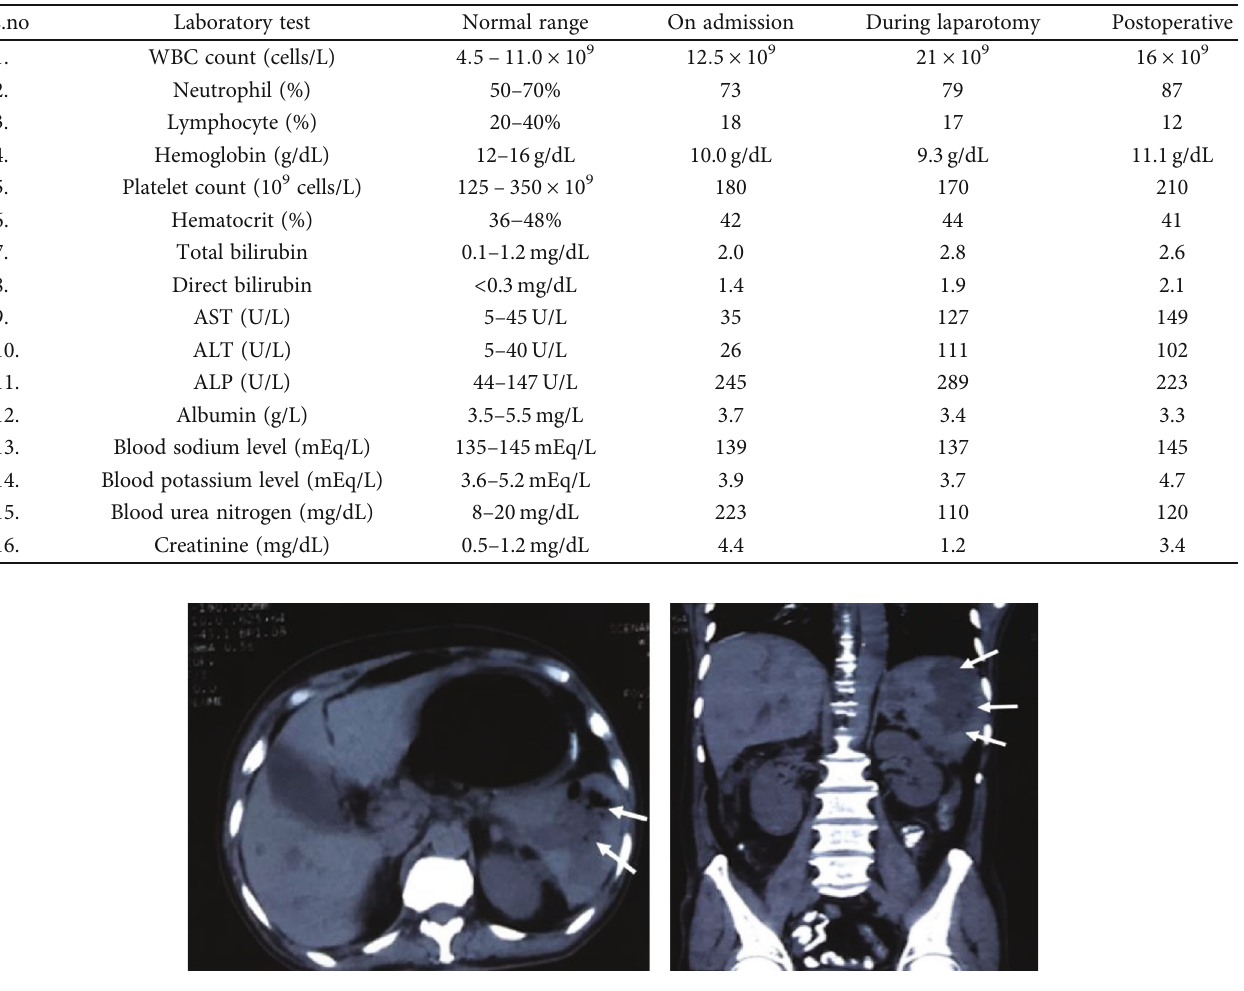
Figure 1: NCCT scan showing the intrasplenic gas-containing collection, consistent with abscess (shown by white neutrophilia (78%). His Renal Function Test (RFT) showed raised urea and creatinine of 223 and 4.4mg/dL, respectively.